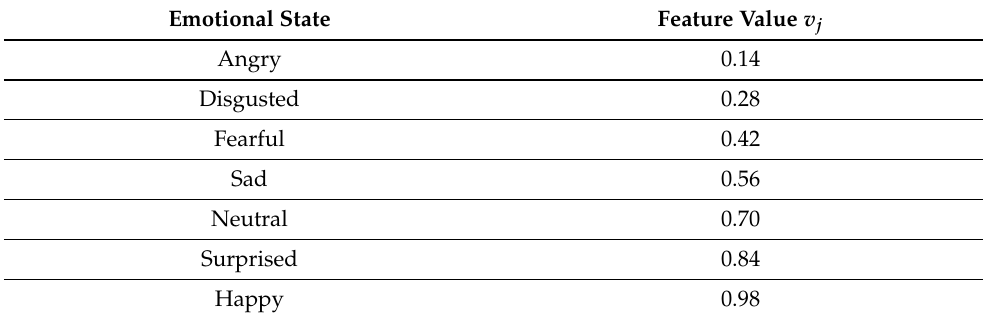
Table 1. Values for socialization feature “emotional